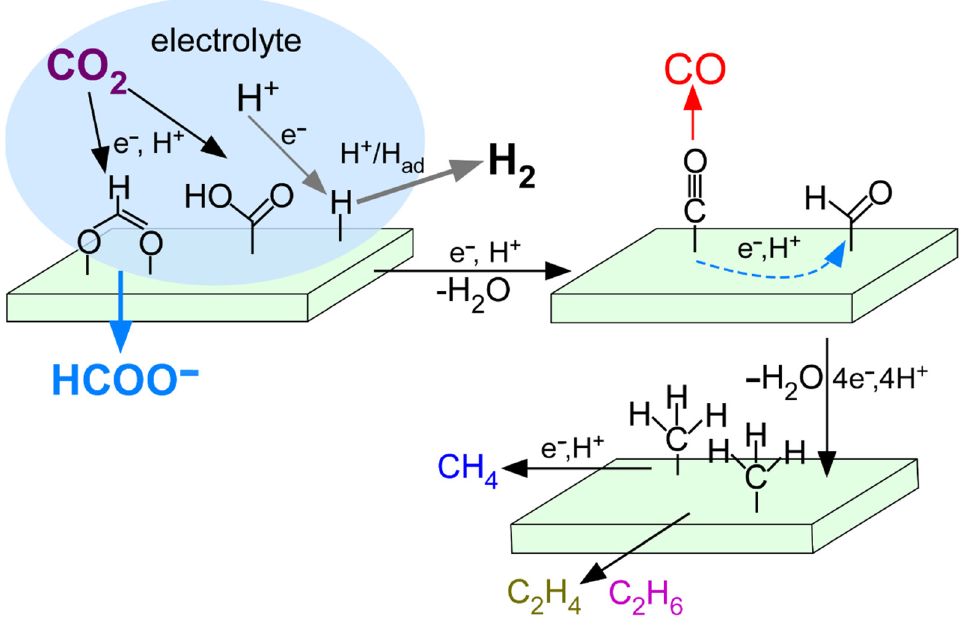
Figure 8. Proposed CO 2 RR mechanism on the basis of the products.